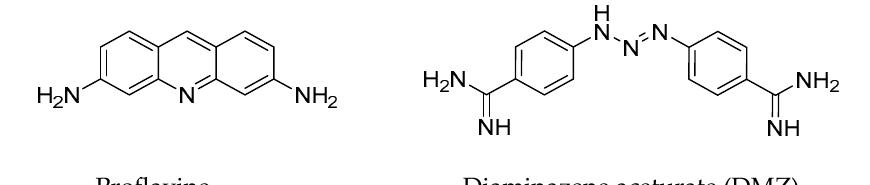
Figure 1. Structures of ligands used in this study.